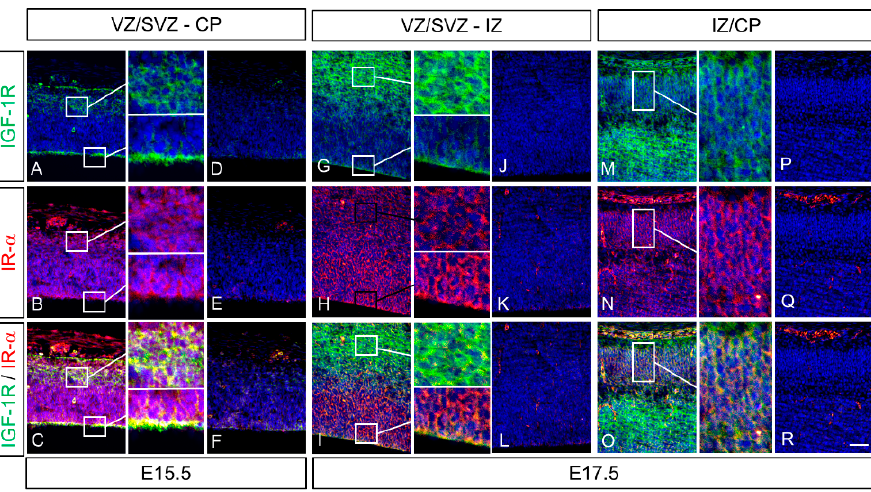
Figure 5. Expression of IGF-1 receptor (IGF-1R) and insulin receptor α (IR- α ) in the fetal dorsal cerebrum at E15.5 and E17.5. IGF-1R (green) and IR- α (red) were widely expressed in the dorsal cerebrum at E15.5 and E17.5 ( A , B , G , H , M , N ). A strong intensified co-localization of IGF-1R and IR- α was observed, especially along the apical surface of the ventricular zone (VZ) and intermediate zone (IZ) ( C , I , O ). The negative controls were stained with normal rabbit IgG ( D – F , J – L , P – R ), respectively). Colocalization of these receptors is denoted in yellow. The nuclei were stained with Hoechst 33342 (blue). Scale bar: 50 µm.